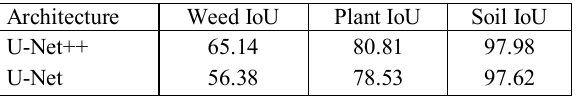
Table 2 . Comparison of IoU for per class in